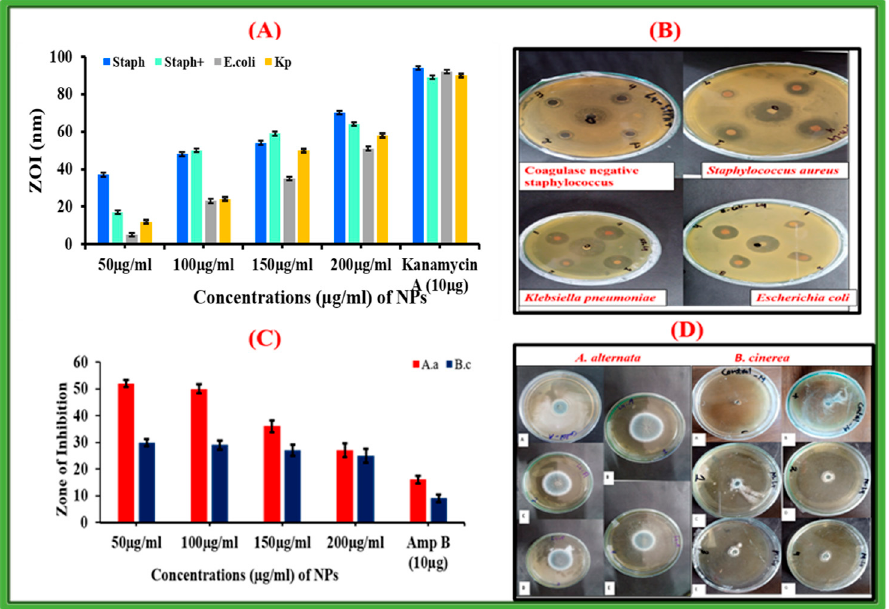
Figure 9. Antimicrobial assays. ( A , B ) Antibacterial assay of zinc oxide nanoparticles; ( C , D ) antifungal assay of zinc oxide nanoparticles.